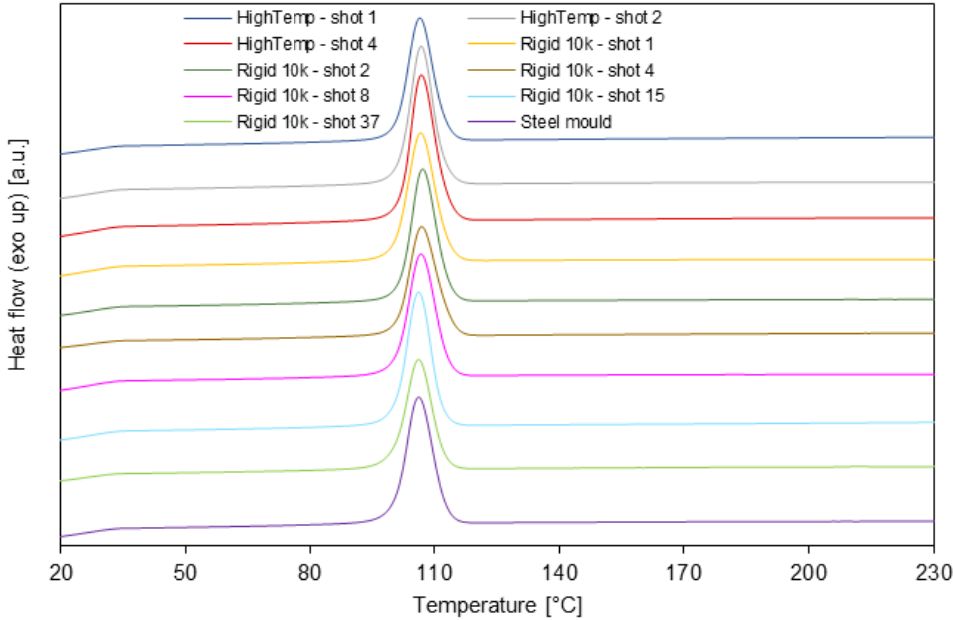
Figure 8. DSC thermograms obtained during the cooling step for PP moulded in different moulds and at different shots.